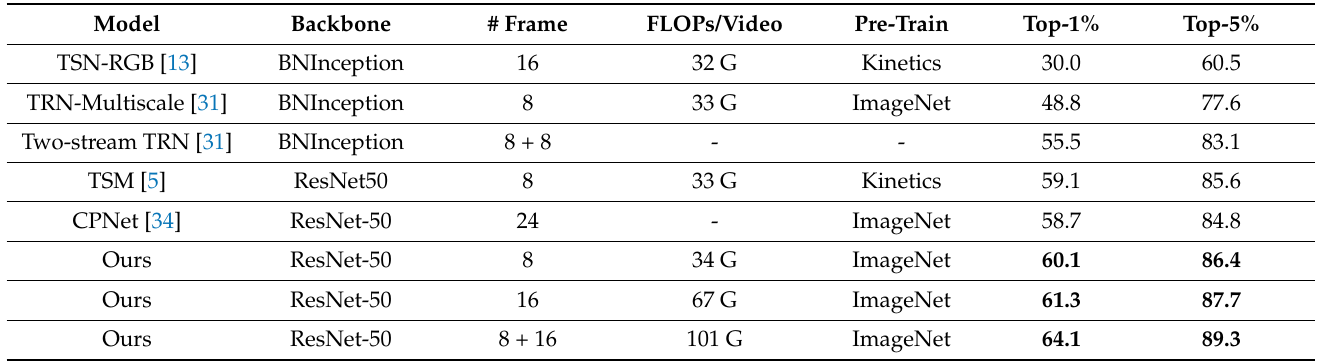
Table 4. Comparison of performance on Something-Something-V2.